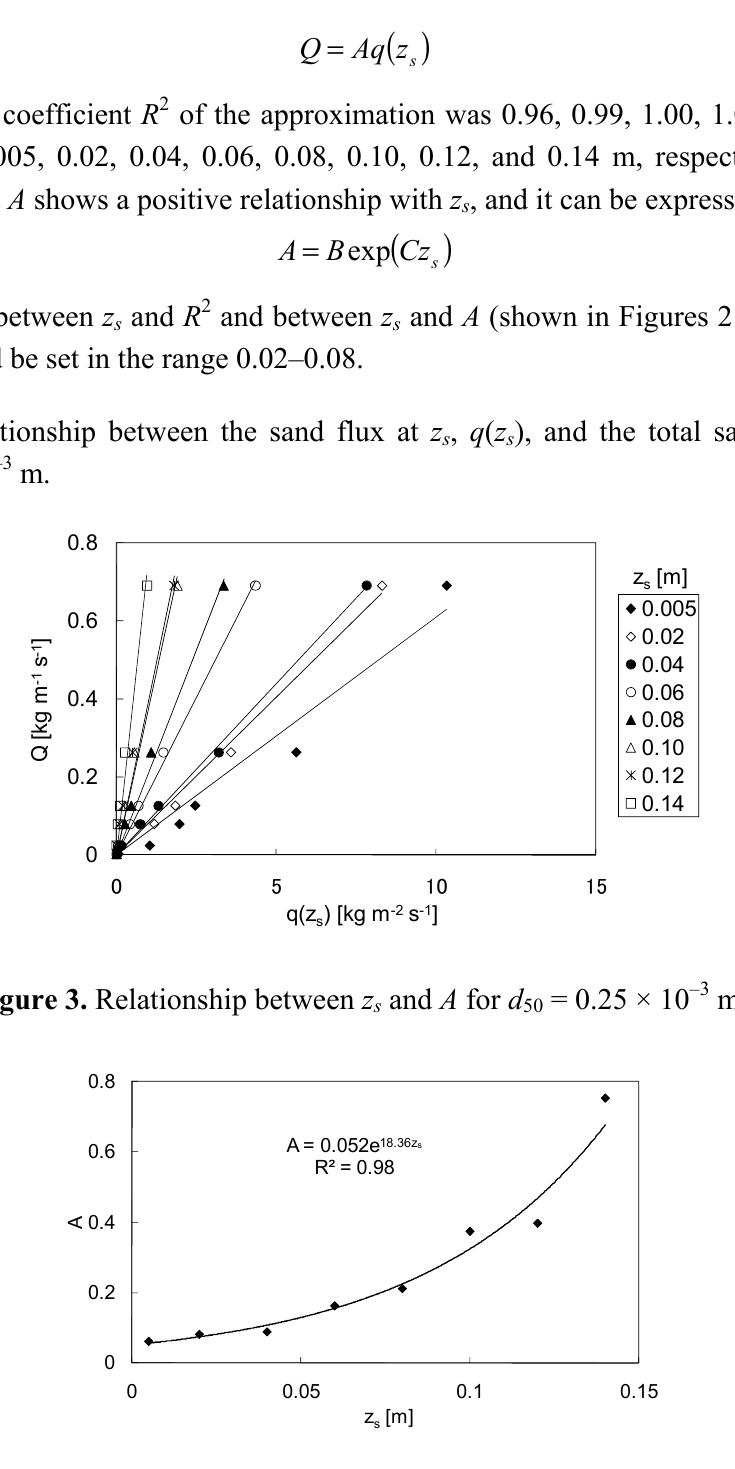
A = 0.052e 18.36z s R² =